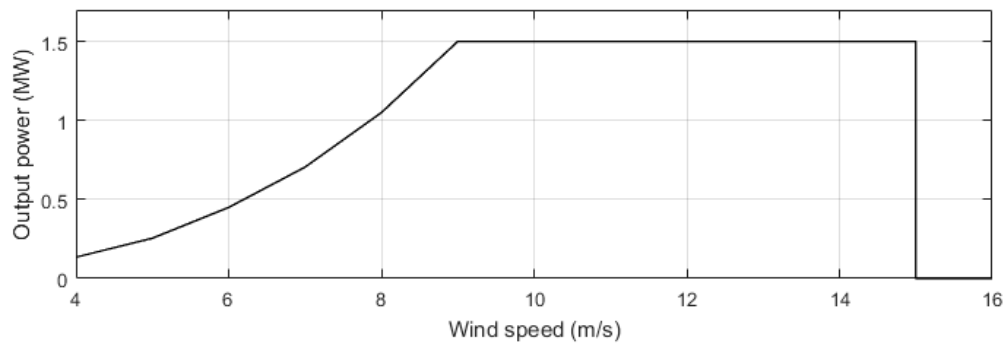
Figure 7. Wind speed-output power curve of the wind turbine model applied in this paper.